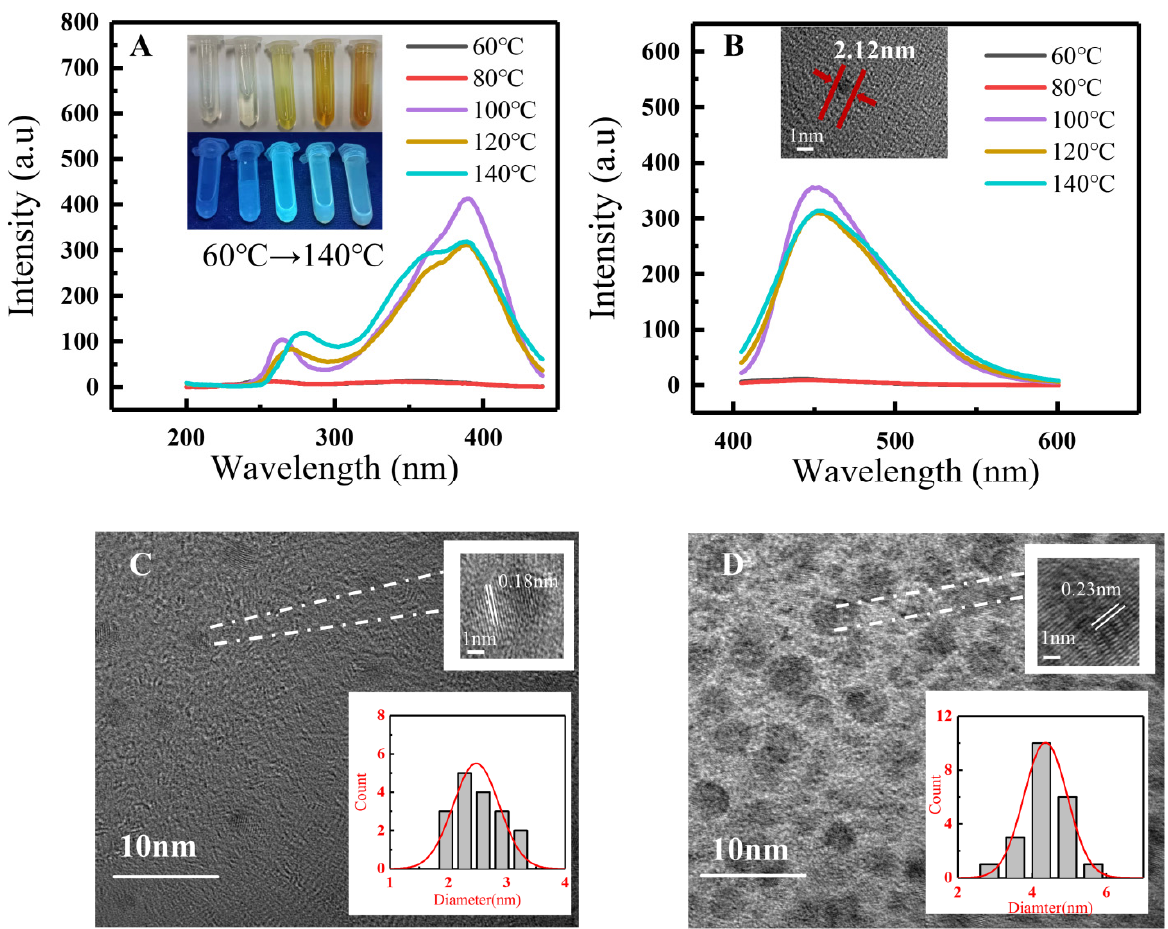
Figure 4. ( A ) Fluorescence excitation spectra and ( B ) emission spectra of the 2.0G PAMAM-DCM PDs ( λ EX = 390 nm). ( C , D ): TEM of 2.0G PAMAM-DCM PDs at 120 ◦ C and 140 ◦ C, respectively. Insets in ( A ) are photographs taken at different temperatures under sunlight and UV light ( λ EX = 365 nm), respectively. Insets in ( B – D ) are HRTEM images of 2.0G PAMAM-DCM PDs at 100 ◦ C, 120 ◦ C, and 140 ◦ C, respectively.